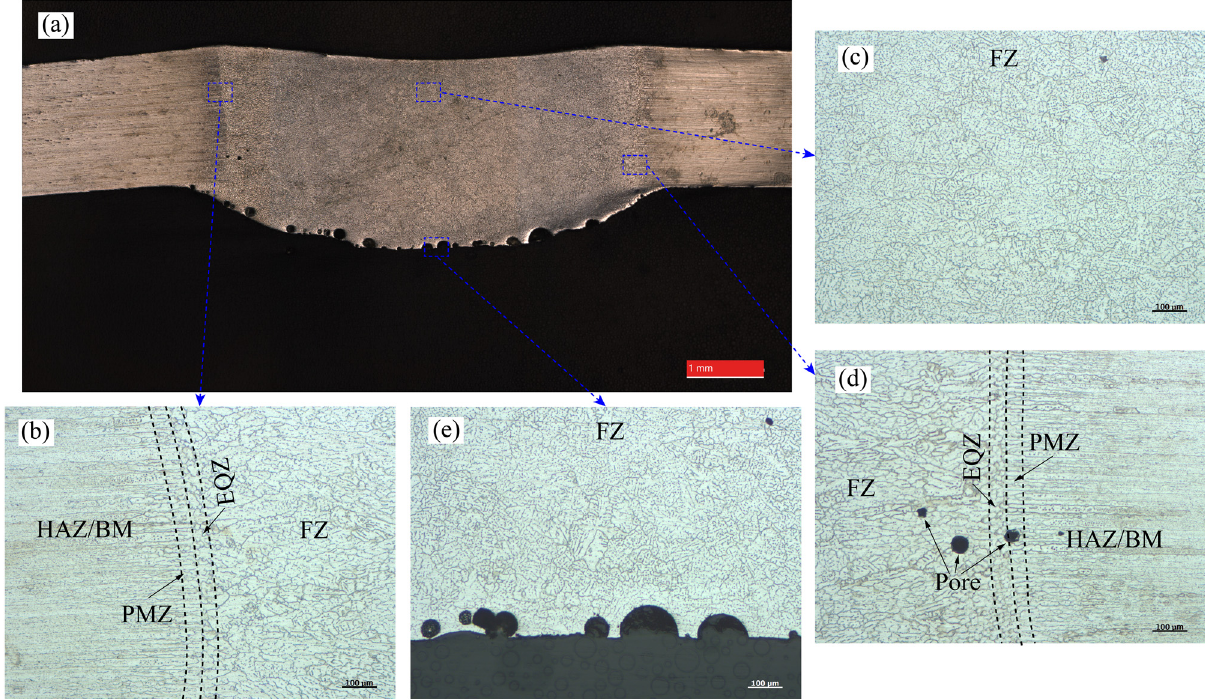
Figure 8: Case 3: metallographic